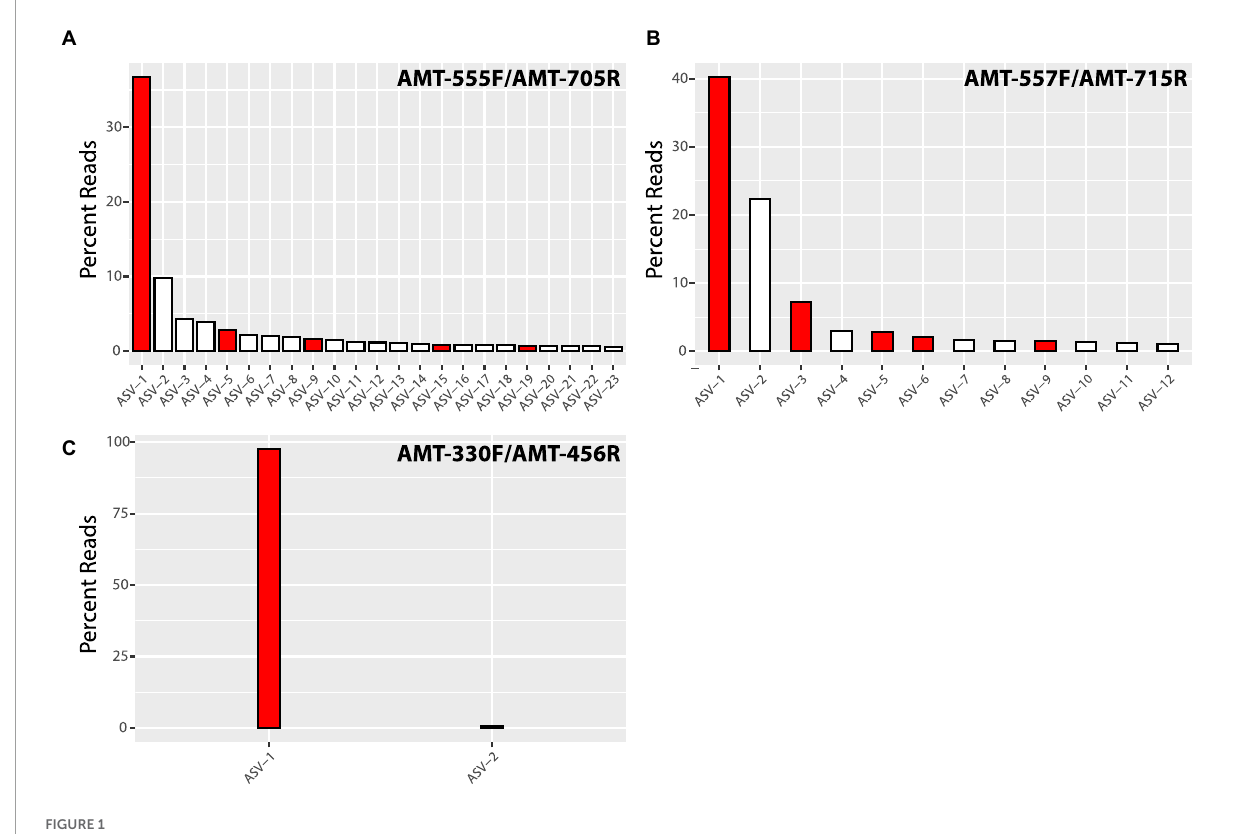
FIGURE1 Bar chart of the percentage of total reads represented by significant amplicon sequence variants (ASVs) amplified by AMT-555F/AMT-705R (A) , AMT-557F/AMT-715R (B) and AMT-330F/AMT-456R (C) primer pairs. We have defined significant ASVs as those accounting for more than 0.5% of total reads. Red bars represent ASVs closely related ( > 95% nucleotide identity) to the A1-Host amt gene, while white bars indicate non-A1-Host related